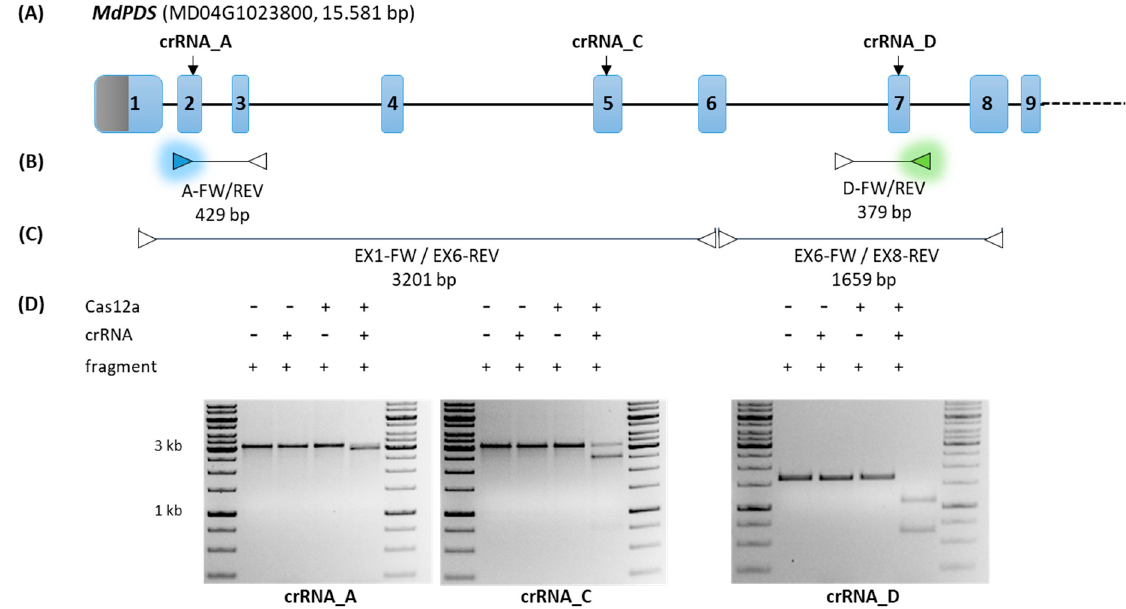
Figure 1. The MdPDS target locus for GE analysis. ( A ) The scheme represents the genomic organization of MdPDS (MD04G1023800) comprising exons one to nine (numbered boxes; 5’-UTR (gray), coding sequence (blue)) and introns (black line). Target sites of crRNAs in coding exon 2 (crRNA_A), exon 5 (crRNA_C), and exon 7 (crRNA_D) are indicated by arrows. ( B , C ) Binding sites of primer pairs used for fluorescent PCR capillary gel electrophoresis ( B ) and DNA cleavage assays ( C ) are represented as triangles. Primers labeled with fluorescent dyes are represented in blue and green. ( D ) For DNA cleavage assays, PCR fragments were amplified from genomic DNA of ‘Gala’ and used as substrates for digestion with pre-assembled Lb Cas12a/crRNA complexes. Experimental controls without the Lb Cas12a/crRNA complex or with only one complex component each were also performed (indicated by + and − ). The resulting products were separated by gel electrophoresis and, dependent on the target site of the respective crRNA, the cleavage of the PCR fragment resulted in different products: crRNA_A (fragment EX1-FW/EX6-REV: 2981 bp + 220 bp); crRNA_C (fragment EX1-FW/EX6-REV: 2576 bp + 626 bp); crRNA_D (fragment EX6-FW/EX8-REV: 1031 bp + 628